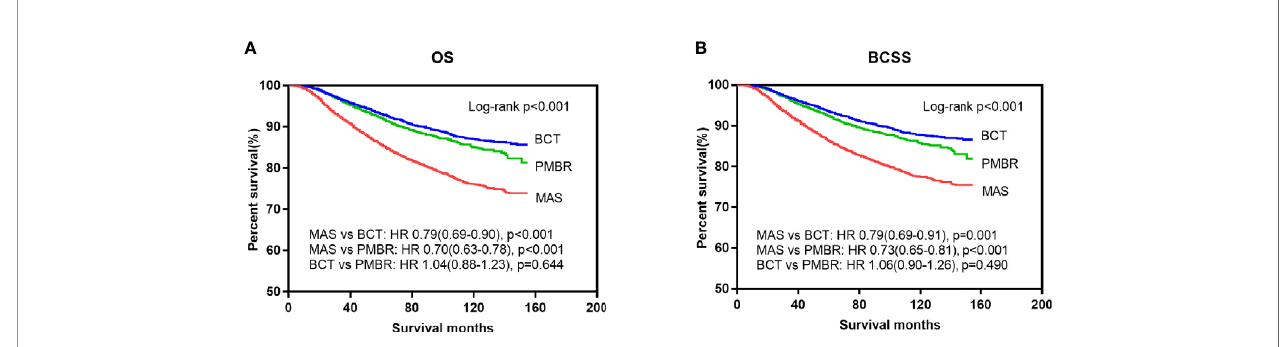
FIGURE 2 | Kaplan – Meier survival curves: OS (A) and BCSS (B) of young women with operable breast cancer according to surgical type. OS, overall survival; BCSS, breast cancer-speci fi c survival; MAS, mastectomy; BCT, breast-conserving therapy; PMBR, post-mastectomy breast reconstruction; HR, hazard ratios.